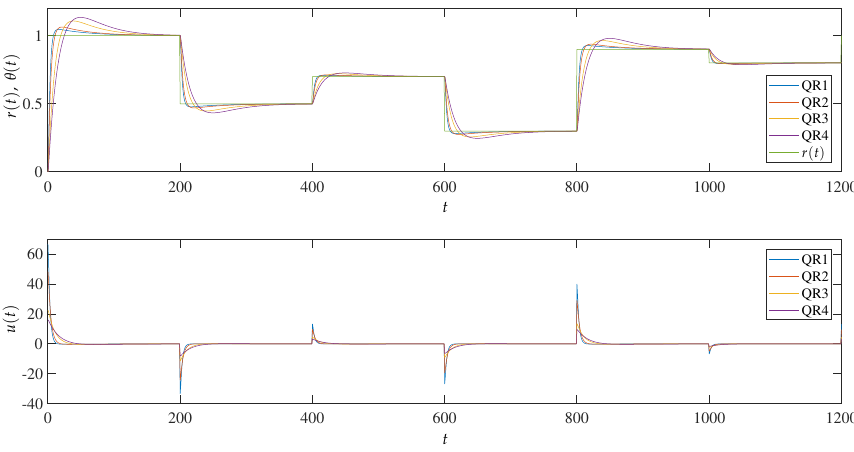
Figure 14. System response with the linear